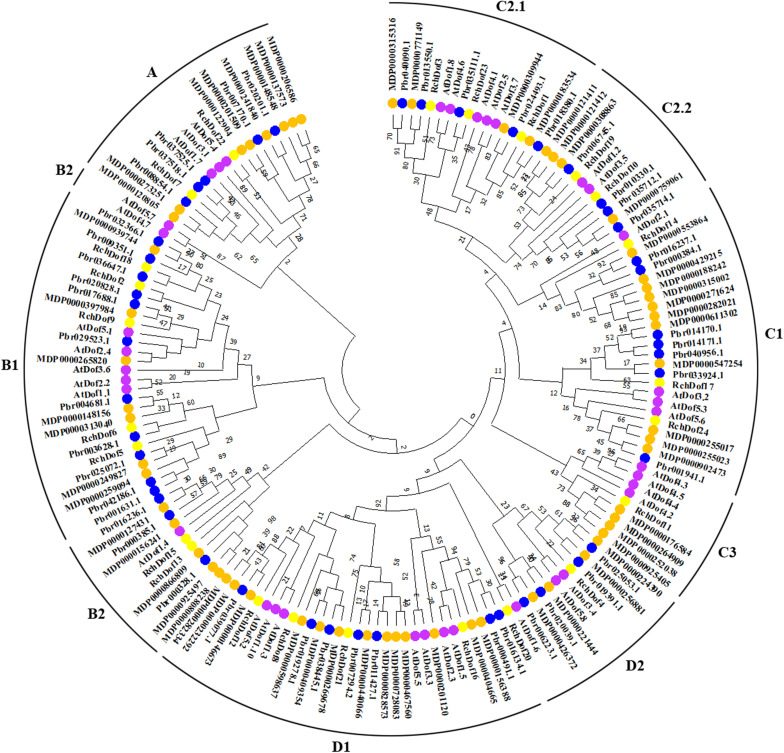
Phylogenetic tree based on Dof proteins from rose, Arabidopsis, apple, and pear. The phylogenetic tree was constructed using the maximum likelihood method. The reliability of the predicted tree was tested using bootstrapping with 1,000 replicates.